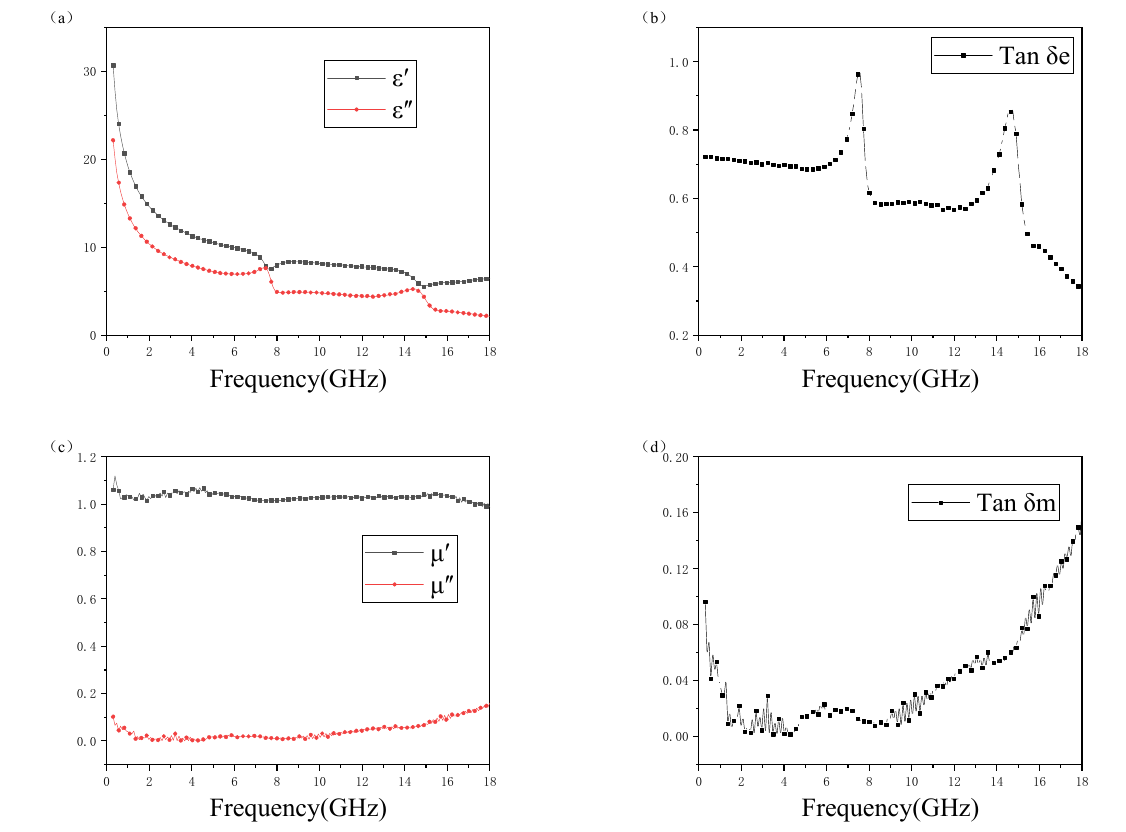
Figure 8. Electromagnetic properties of composites. (a) Real part ( ε′ ) and imaginary part ( ε″ ). (b) Dielectric loss tangent Tan δ e . (c) Real part ( μ′ ) and imaginary part ( μ″ ). (d) Magnetic loss tangent Tan δ m . It can be observed from Figure 8c,d that the values of µ (cid:48) , µ (cid:48)(cid:48) , and tan δ m fluctuate in the ranges of 0.98–1.12, 0–0.16, and 0–0.16, respectively. Such values were presented because the composite is not